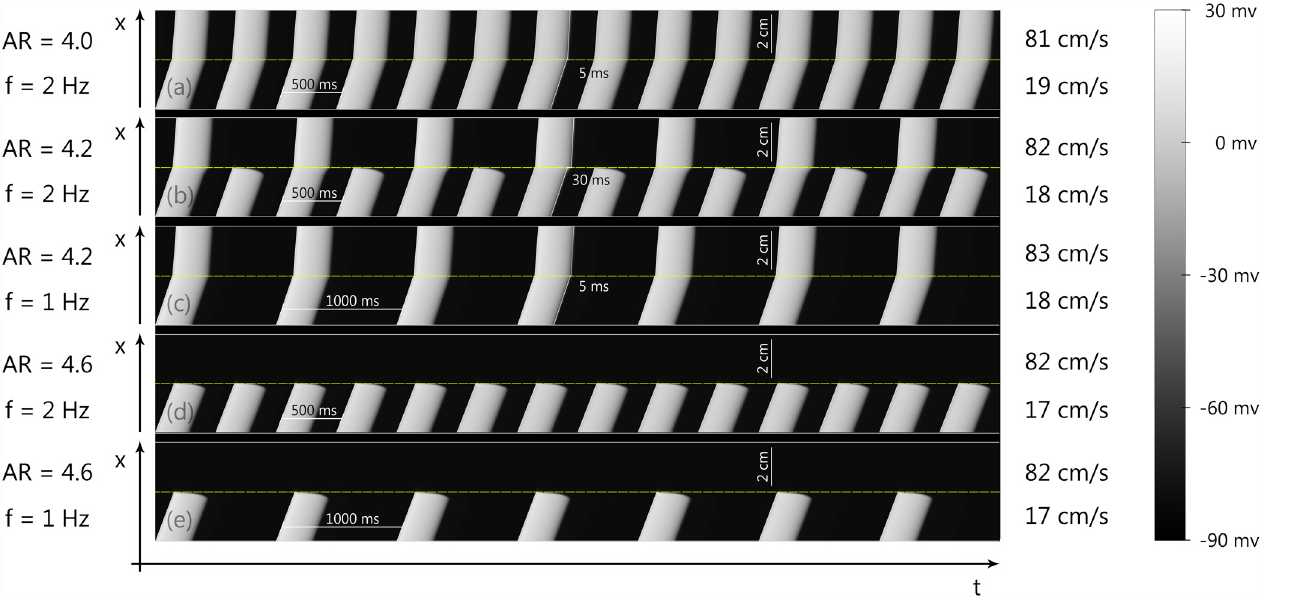
Fig 2. Wave propagation through the boundary of abrupt change of anisotropy in cardiac tissue for various ARs and frequencies of stimulation (f). Figure shows space(x) – time(t) plots of wave propagation along 1D cables with abrupt changes of conductivity, representing abrupt changes of fiber orientation in 2D cardiac tissue. The details of the computational setup are represented in Fig 1 and in section 0.3. (a, c) no block occurs, (b) 1:2 block, (d, e) complete block at the boundary.